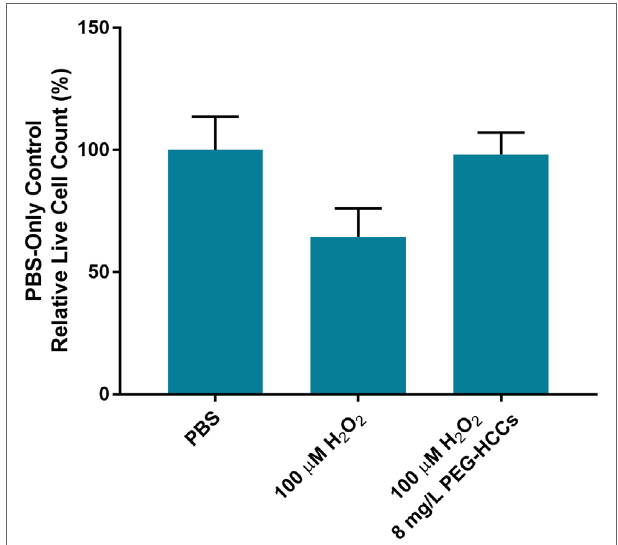
FigUre 1 | Cell viability following addition of hydrogen peroxide to cultured brain endothelial cells (b.End3). Live cell counts (Live/Dead cell viability assay) per well is presented on y -axis as mean and SD of replicates. 100 µM H 2 O 2 was added and 15 min later either media or hydrophilic carbon clusters, conjugated to poly(ethylene glycol) (PEG-HCCs) (8 mg/mL) was added and live cell/well assessed the following day. H 2 O 2 reduced cell viability by 50%, which was completely restored by